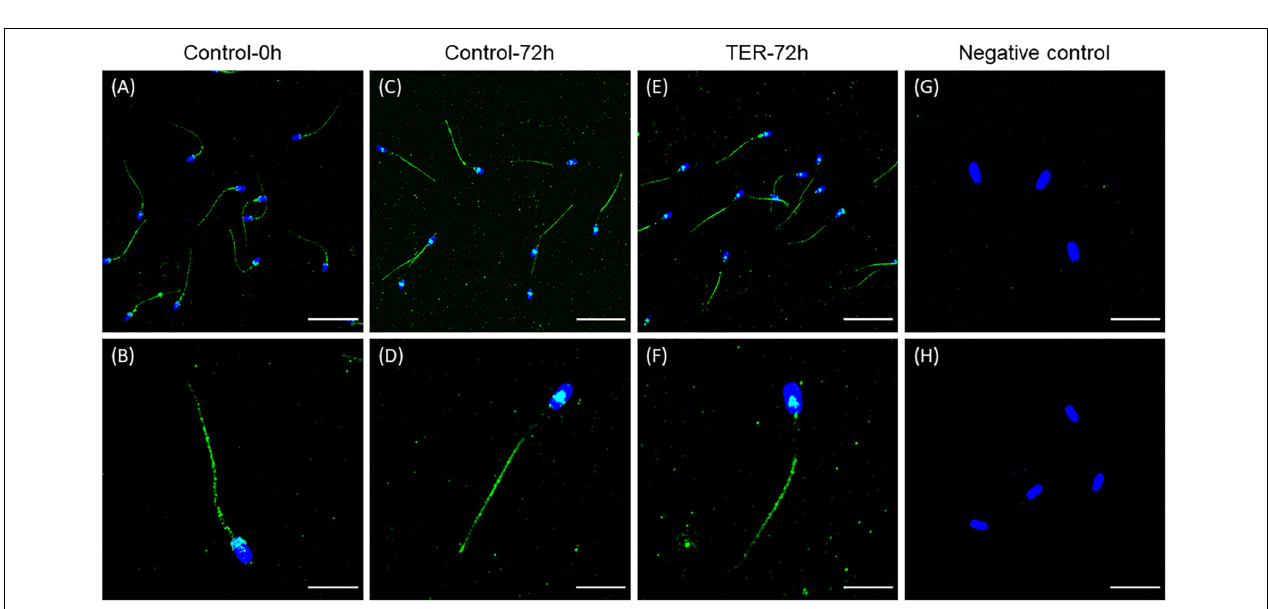
FIGURE 1 | Immunoblotting analysis of GSTP1. Pig sperm lysates were incubated with (A) anti-GSTP1 antibody, (B) anti- α -tubulin antibody, and (C) total protein bands. Lanes: MW (kDa), molecular weight; Control-0h, semen samples at 0 h of storage; Control-72h, vehicle control (dimethyl sulfoxide; DMSO) semen samples at 72 h of storage at 17 ◦ C; TER-72h, semen samples treated with 100 µ M ezatiostat (TER) for 72 h of storage at 17 ◦ C. Alpha-tubulin (anti-tubulin) and TGX Stain-Free TM (total protein) were performed as complementary loading controls. These results are representative of three independent experiments ( n = 3).